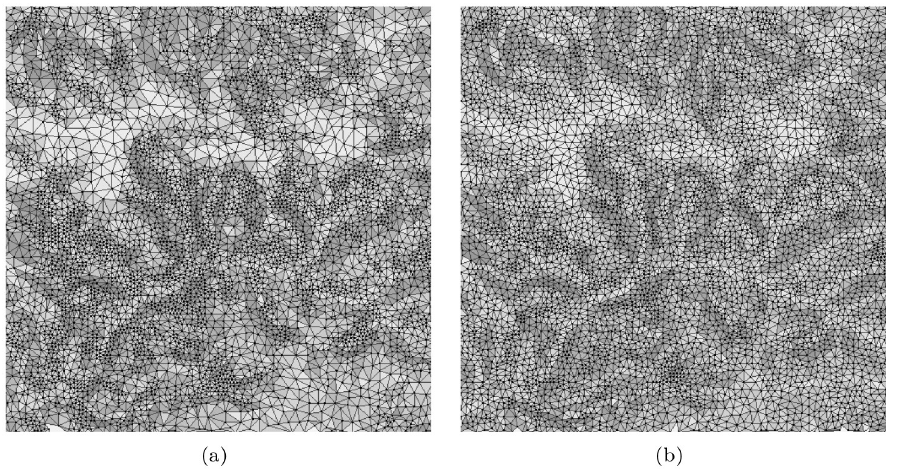
Fig 7. The mesh models of the samples obtained from the low resolution version of the Fig 2(b).